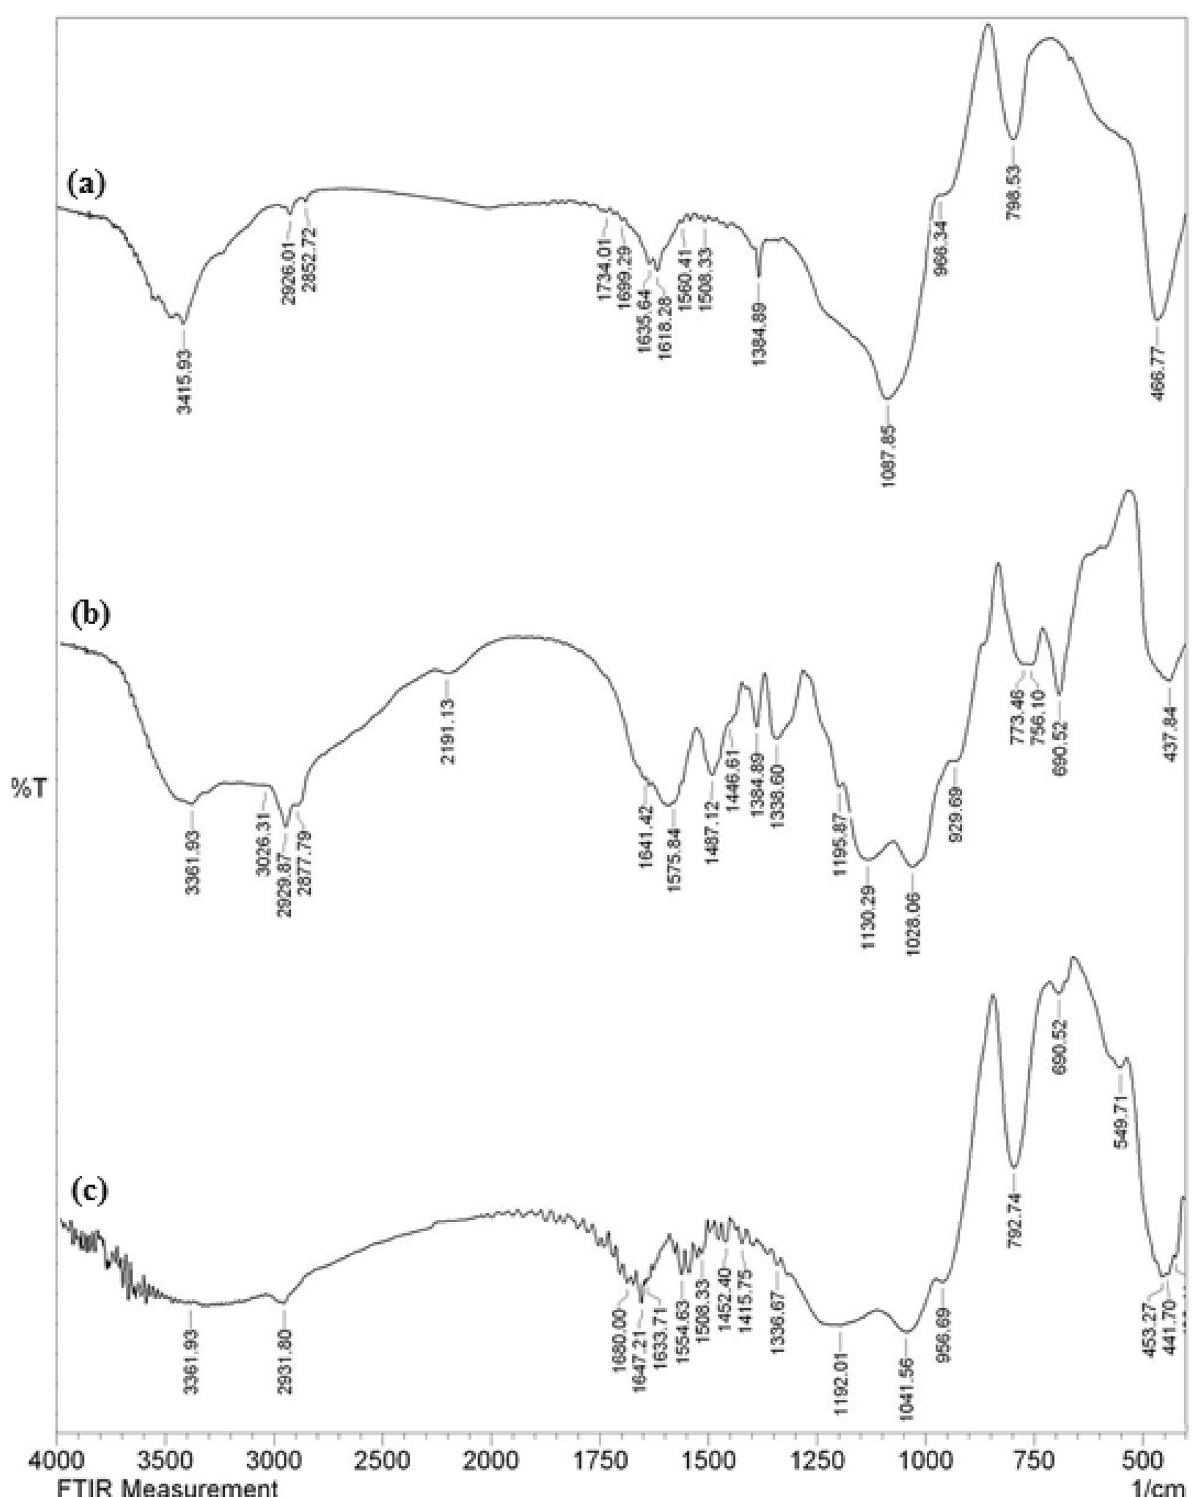
Figure 1. FT-IR spectra of ( a ) KIT-5, ( b ) KIT-5-biguanidine, and ( c )